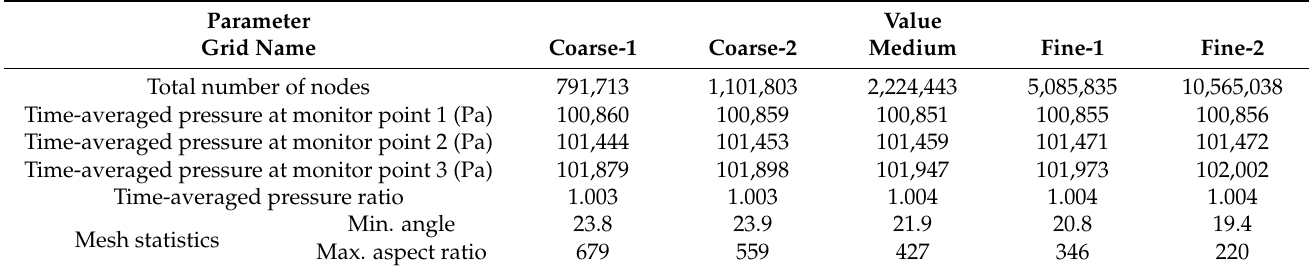
Table 13. Effect of mesh size on time ‐ averaged pressure and mesh quality. Parameter